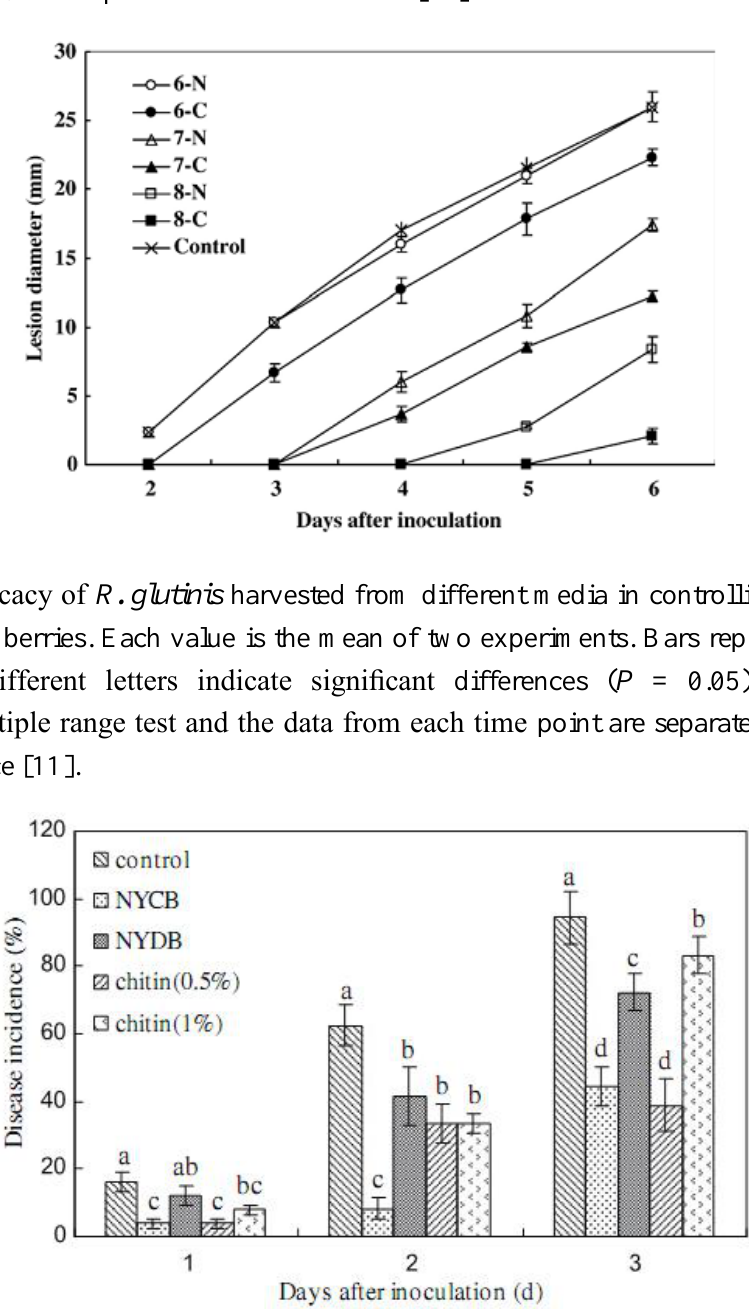
Figure 6. Efficacy of Cryptococcus laurentii in inhibiting the lesion diameter of blue mold caused by Penicillium expansum in pear fruit wounds at 25 °C. Treatment with water and inoculated with P. expansum was applied as the control. Bars represent standard errors.